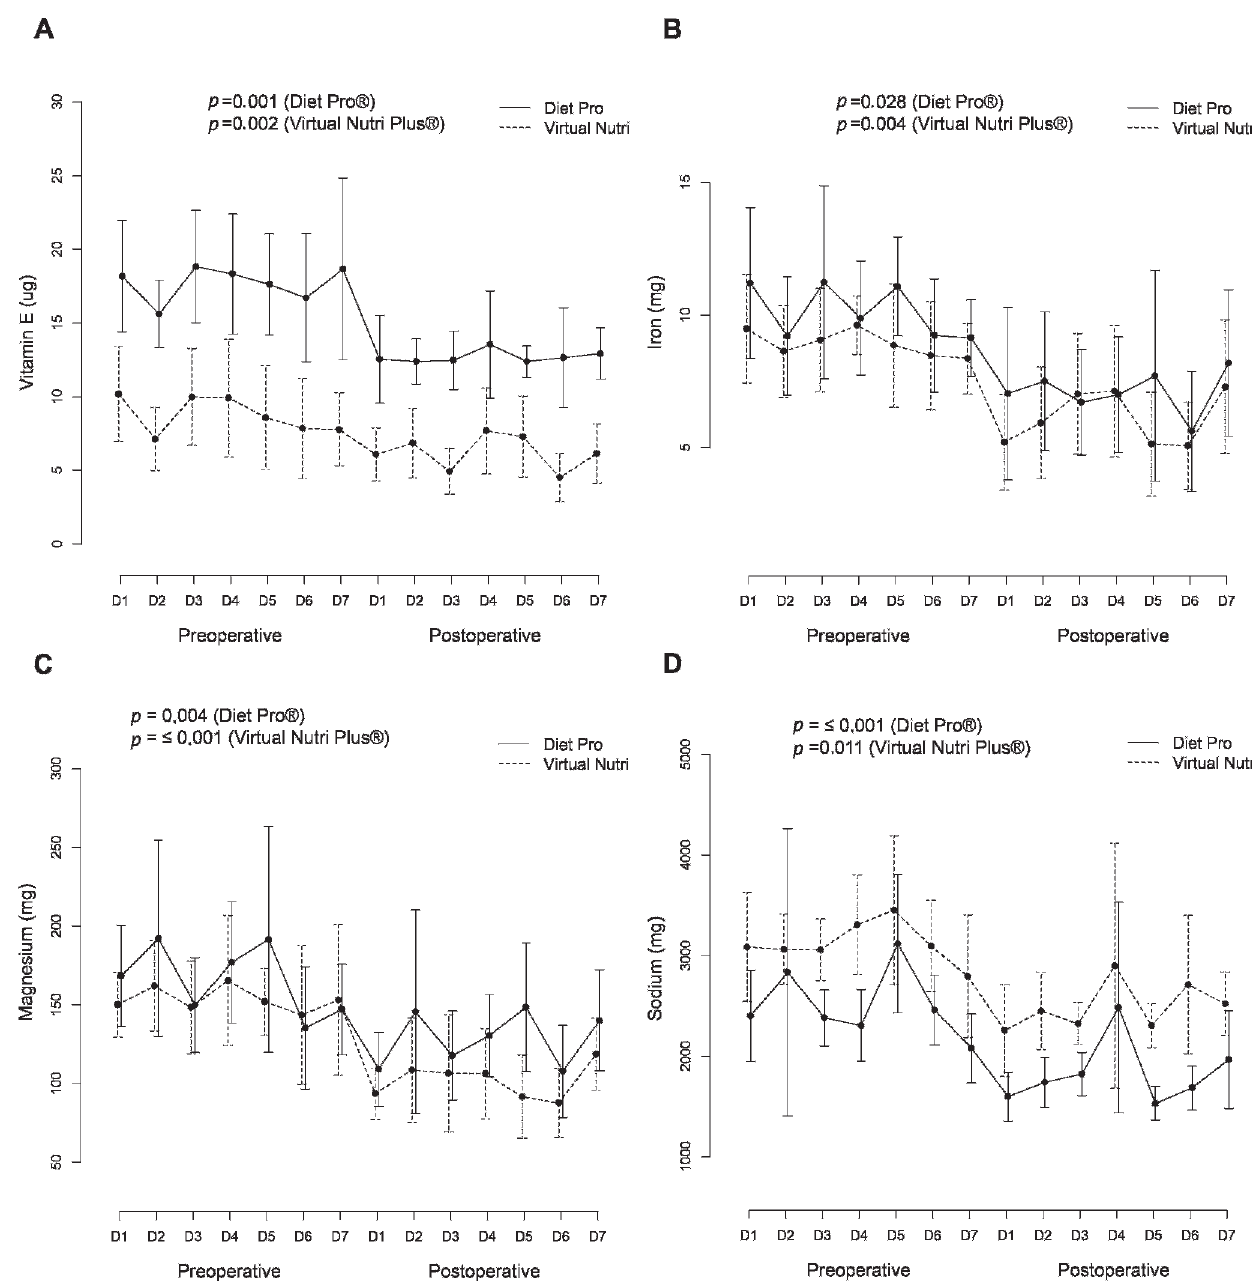
Figure 3 - Changes in the ingestion of micronutrients by obese women with type 2 diabetes mellitus (n=10) before and 3 months after a Roux-en Y gastric bypass. Changes in: (A) vitamin E, (B) iron, (C) magnesium and (D)